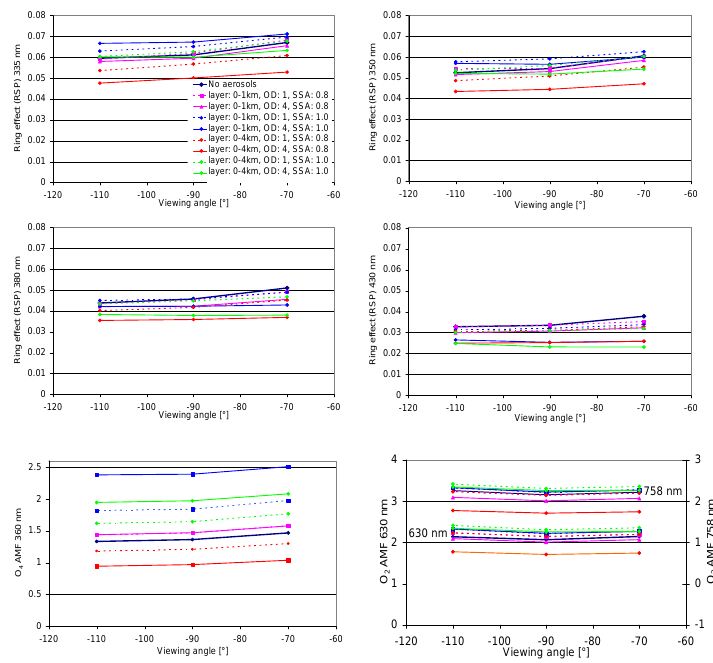
Fig. A2 Dependence of the Ring effect and the O 2 and O 4 absorptions on the viewing zenith angle of the satellite instrument (angles larger than -90° indicate eastern direction). The calculations are performed for SZA of 30° with the sun in eastern direction. The aerosol asymmetry parameter was assumed to be 0.68. For 758 nm the surface albedo was set to 20%, for 630 nm to 10%, and for all other wavelengths to 5%.